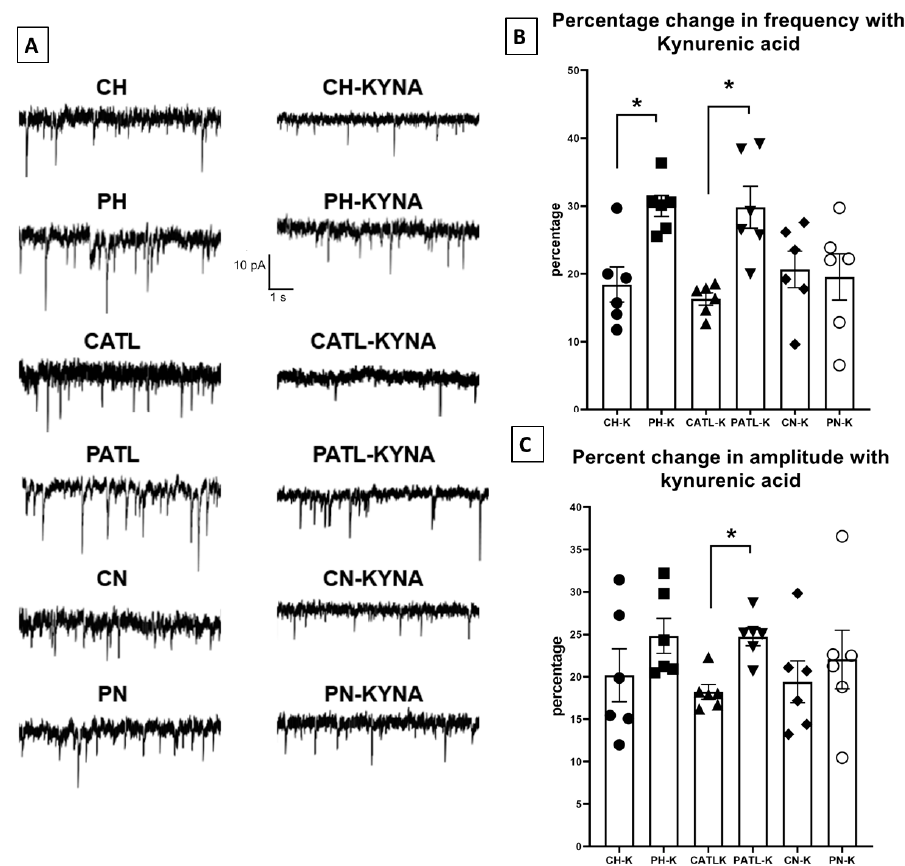
Figure 4. Spontaneous excitatory postsynaptic currents were suppressed after 30 min of perfusion with 10 μ M kynurenic acid in the hippocampal and ATL samples of the TLE rats. ( A ) Representative traces in control condition and after perfusion with kynurenic acid from different groups. ( B , C ) Per- centage reduction in frequency and amplitude of the spontaneous excitatory postsynaptic currents after 30 min perfusion with kynurenic acid. CH, control hippocampus; PH, pilocarpine hippocampus; CATL, control ATL; PATL, pilocarpine ATL; CN, control neocortex; PN, pilocarpine neocortex; KYNA, kynurenic acid. Control rat, n = 10; TLE rat, n = 10; Data represented as mean ± SEM; * p < 0.05, Mann–Whitney U